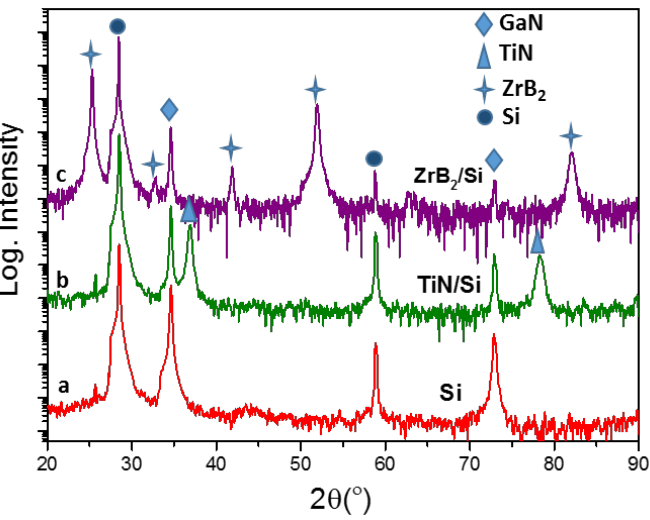
Figure 6. θ /2 θ scan XRD patterns of GaN NRs grown on various template/substrates ( a ) Si, ( b ) TiN/Si, and ( c ) ZrB 2 /Si.